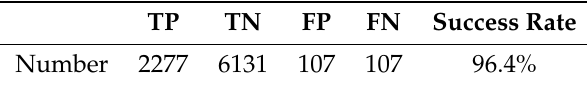
Table 5. The result of the positioning polar body.